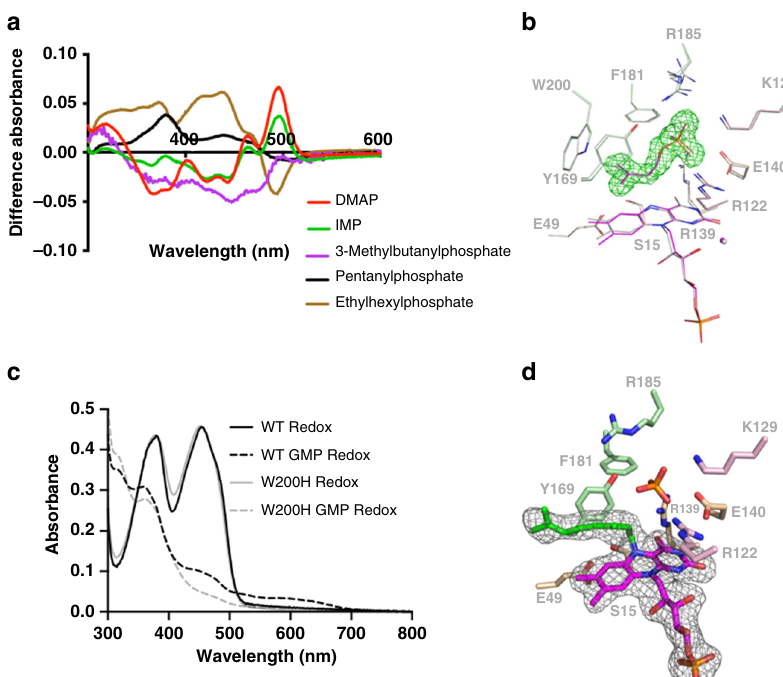
Fig. 3 The N5-prenylation step in UbiX occurs via S N 1. a Difference spectra following addition of various DMAP-like alkyl-phosphate compounds with WT Pa UbiX, indicative of binding in close proximity of the FMN by all the compounds tested. Structures of compounds can be found in Supplementary Fig 3. b The crystal structure of the Pa UbiX: FMNH 2 :IMP complex superposed with previously determined Pa UbiX:FMN:DMAP (4ZAF) in grey. The omit polder map corresponding to bound IMP is shown in green mesh contoured at 5 sigma. Residues are coloured according to Pa UbiX monomer. c UV – Vis spectra following oxidation of FMNH 2 bound WT Pa UbiX and the W200H variant incubated with geranyl monophosphate. d The crystal structure of Pa UbiX W200H with an N5 geranyl adduct (green) following incubation of reduced crystals with geranyl monophosphate. Omit polder map corresponding to the bound geranyl N5 FMN shown in grey mesh contoured at 4 sigma. The W200H mutation is not visible due to disorder of the C-terminus. Stereo images of b and d are available in Supplementary Figs. 4 and 5,